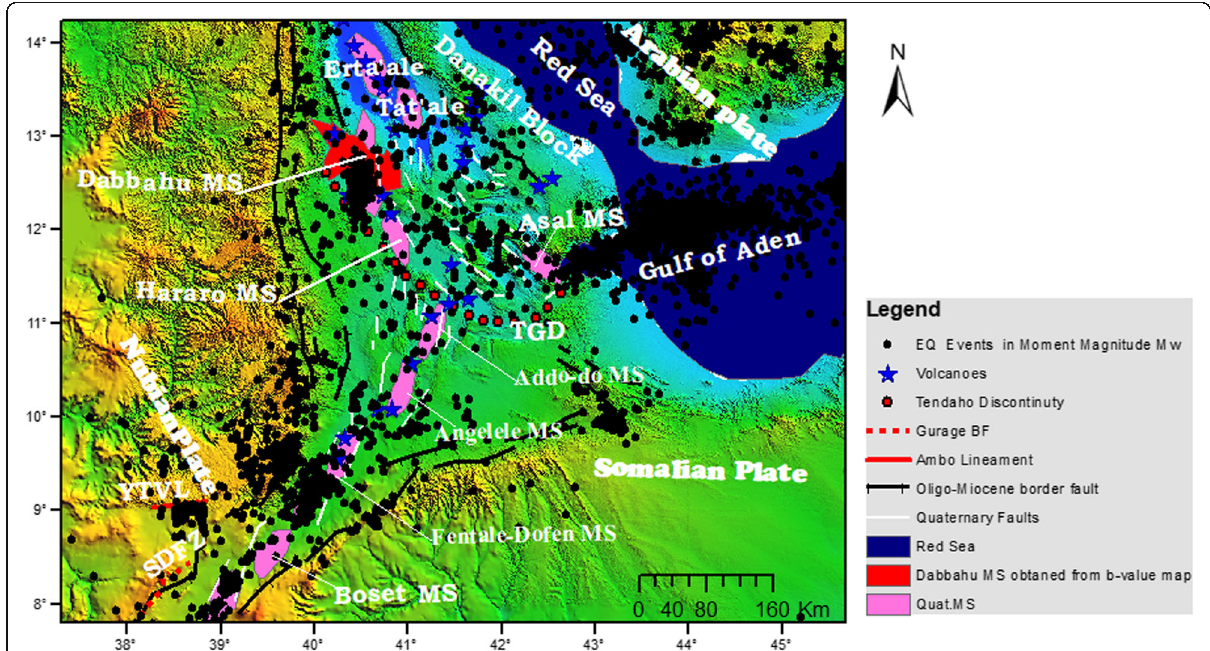
Fig. 13 Location of the Dabbahu rift segment within the Afar triple junction zone; major fault zones. Danakil Block is a microplate between the Nubian and Arabian plates. Red shading indicates 50 km-long magmatic segments (MS) — zones of dense faulting and aligned Quaternary eruptive centers — the current locus of strain within Afar (after C J Ebinger et al., 2008, b and reference therin). The black dots show the earthquake events in moment magnitude scale Mw from this study superimposed on a digital elevation model (Shuttle Radar Topography Mission data-30 m resolution). Inset: the location of SDFZ: Silti-Debre Zeit Fault Zone, YTVL: Yerer Tulu-Volcano Lineament, Red solid line: Ambo Lineament, Red doted line: Guraghe BF-Gurage border Fault, the curved formed by red dotes is TGD:Tendaho-Goba ’ aDiscontinuity, The blue star shows the Volcanoes in the rift, and the red polygon shows high b-value from Fig. 9 representing the Dabbahu Magmatic